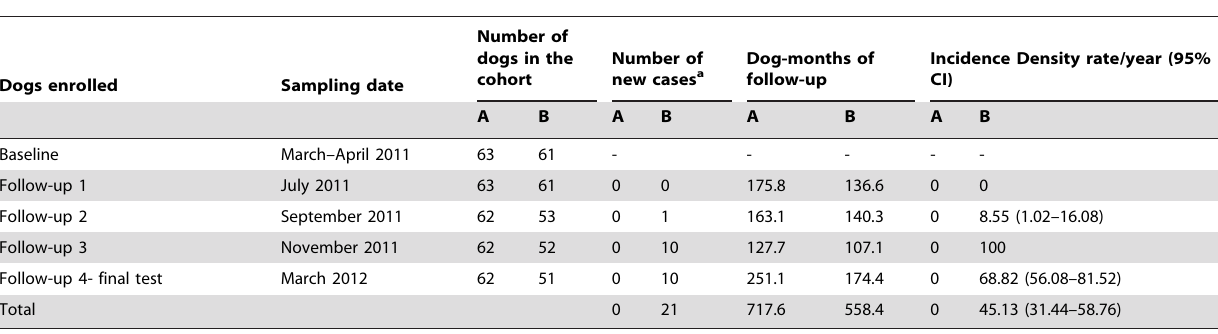
Table 1. Incidence density rate (IDR) of leishmaniosis in dogs from the collared (A) and uncollared control (B) Groups.